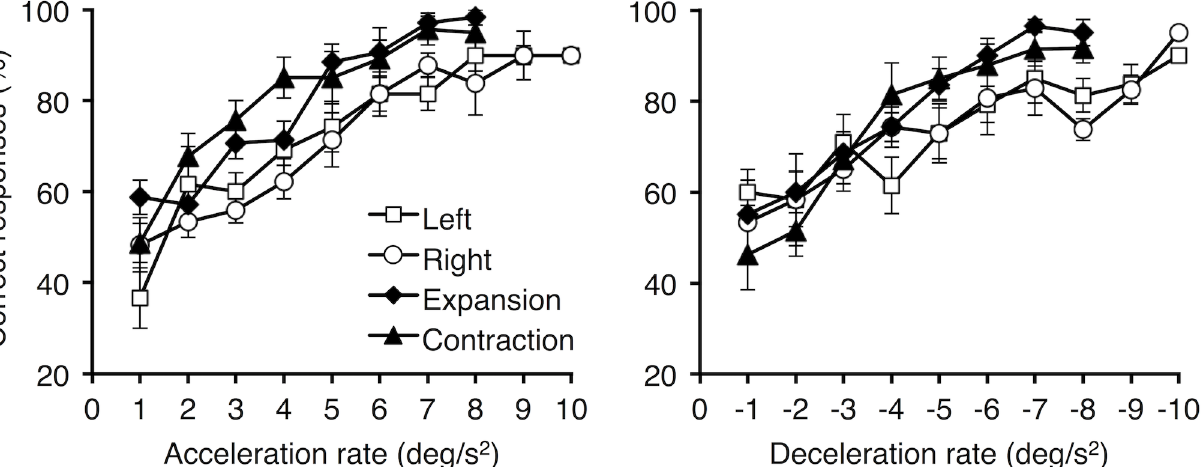
Fig 1. Mean percentage of correct response trials as a function of pattern direction. Acceleration conditions on left and deceleration conditions on right. Error bars are ± 1 SEM .